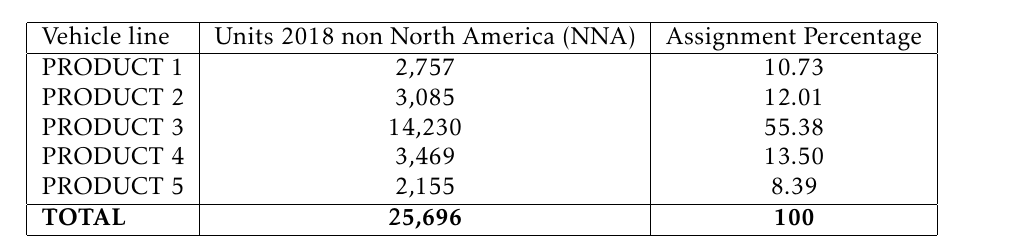
Table 1. Sales 2018.